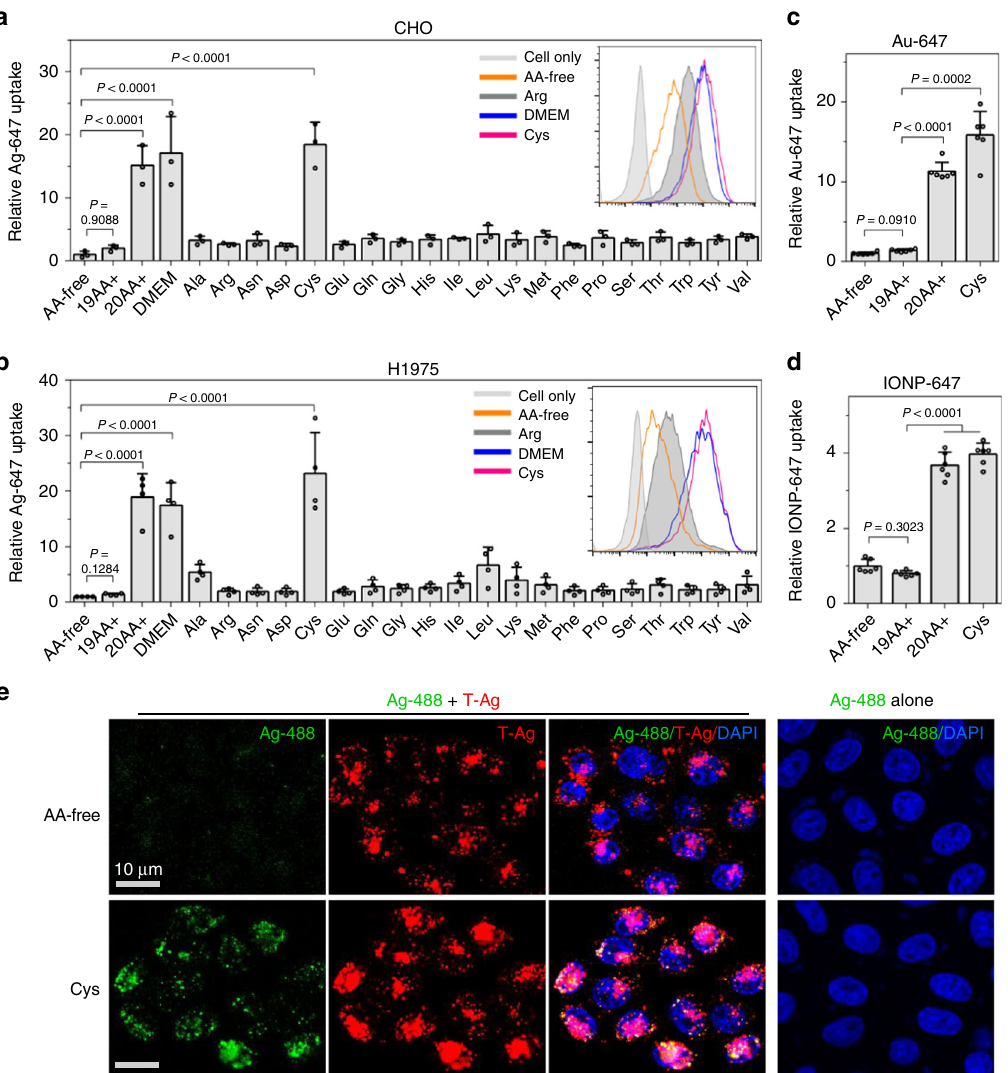
Fig. 4 Extracellular Cysteine stimulates the T-NP-induced bystander uptake. a , b Bystander uptake of Ag-647 in cells cultured in media containing different amino acid compositions. CHO ( a ) and H1975 ( b ) cells were incubated with Ag-647 and T-Ag in AA-free, 19AA + , 20AA + , DMEM or individual AA medium. After etching and washing, the fl uorescence intensity per cell of internalized Ag-647 was determined by fl ow cytometry, and normalized to that in AA-free medium. Data are expressed as mean ± s.d. ( n = 3 in a , n = 4 in b ). The insertion in a , b are the representative fl ow cytometry histograms. c , d CHO cells were incubated with T-Ag and Au-647 ( c ) or IONP-647 ( d ) in AA-free, 19AA + , 20AA + , and Cys medium. The internalized NPs as fl uorescence intensity per cell was normalized to that in AA-free medium ( n = 6). All quanti fi ed data a – d were analyzed using one-way ANOVA with Tukey ’ s multiple comparisons test and are presented as mean ± s.d. One-way ANOVA, a F = 35.772, P = 0.0050; b F = 45.256, P = 0.0004; c F = 24.358, P = 0.0183; d F = 102.60, P = 0.0016. e Confocal microscope images of CHO cells after incubation with T-Ag and Ag-488 in AA-free (upper) and Cys (bottom) medium. Three independent experiments ( n = 3) were performed and representative images are shown here. Scale bars, 10 µ m. Source data